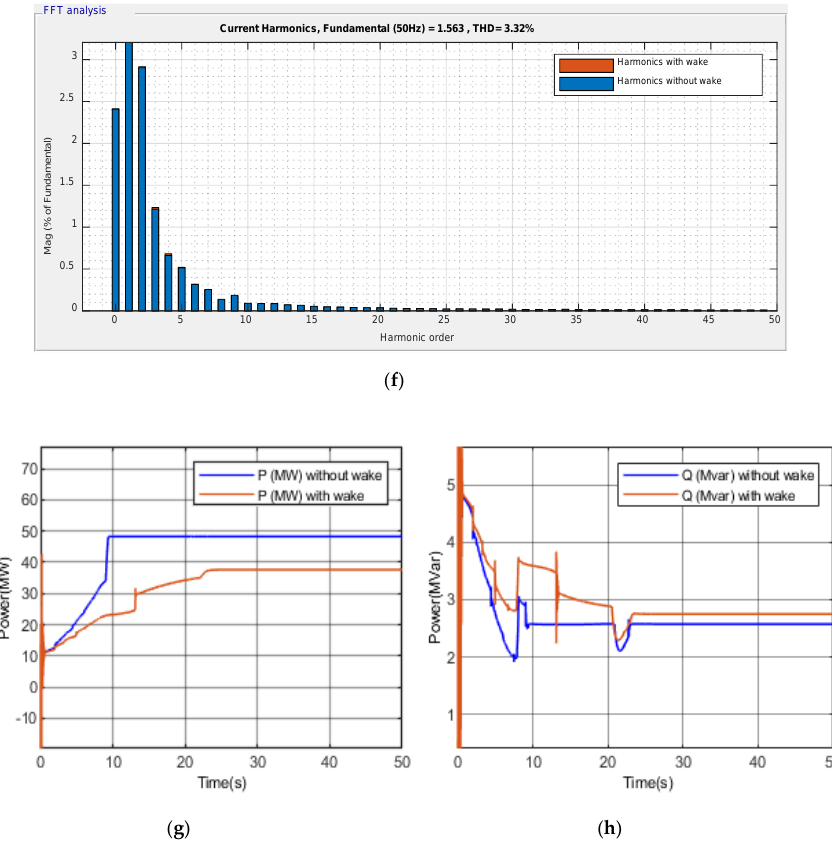
Figure 4. Case-1, Scenario 1 (1a–1b): ( a ) Voltage (V) at PCC; ( b ) frequency (F) at PCC; ( c ) PF at PCC; ( d ) impedance (Z) vs. F; ( e ) voltage harmonics; ( f ) current harmonics; ( g ) P-trend; and ( h ) Q-trend.